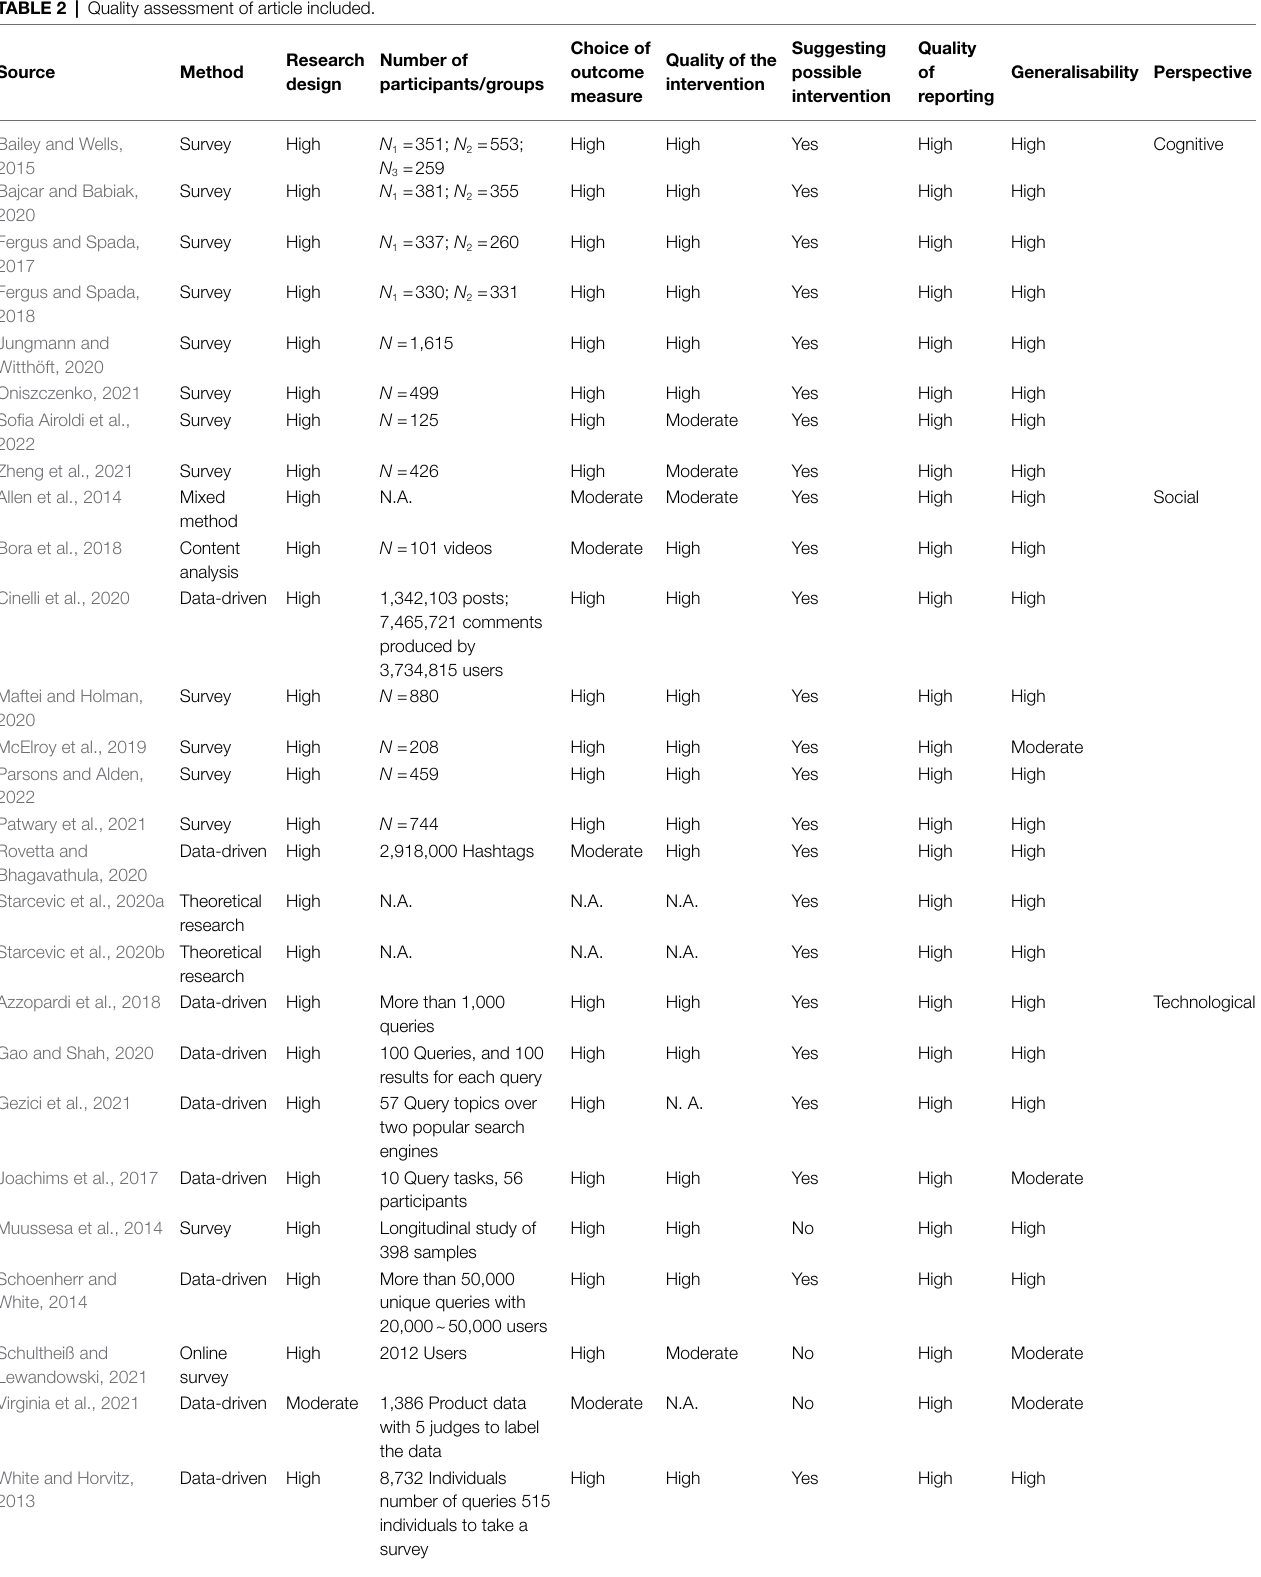
TABLE 2 | Quality assessment of article